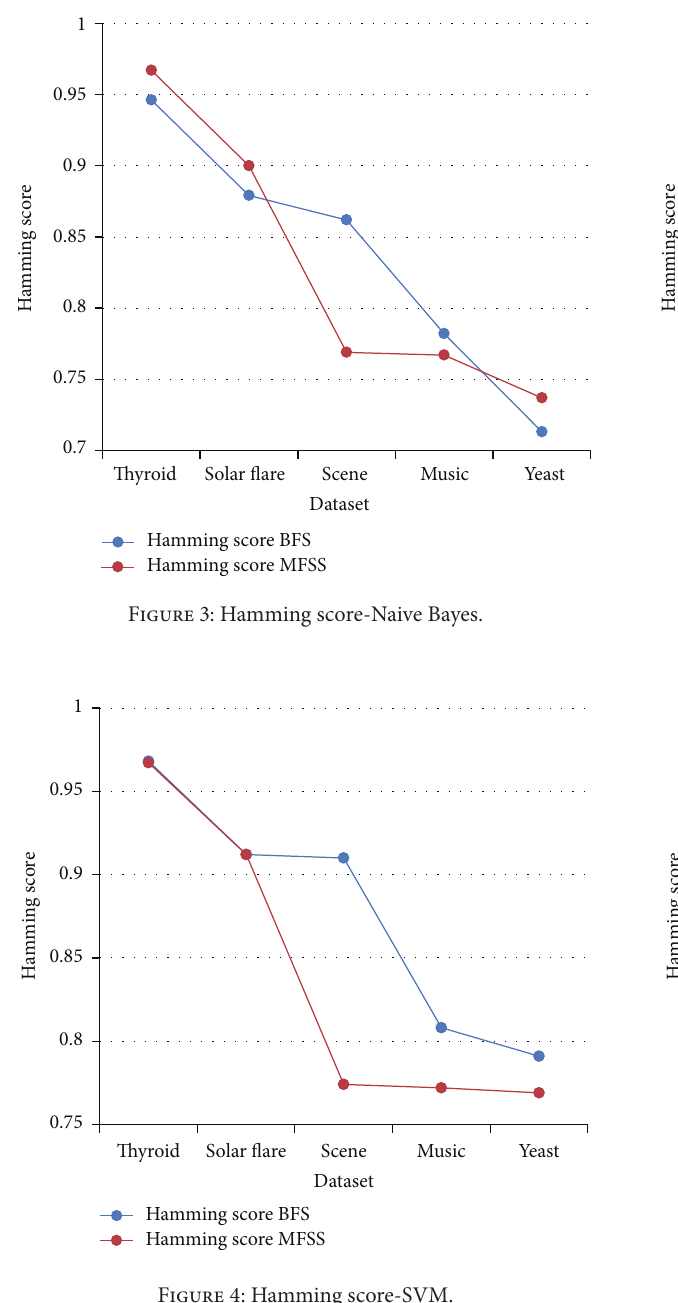
Figure 6: Hamming